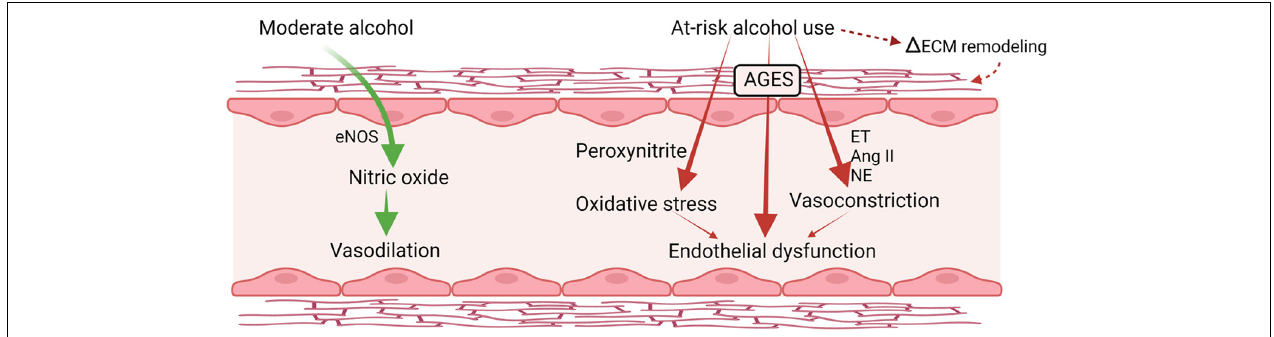
FIGURE 4 | Alcohol-induced biphasic effects on endothelial function. Acutely, moderate doses of alcohol increase production of nitric oxide and result in transient vasodilation. Chronic, heavy alcohol consumption produces oxidative stress and activates vasoconstrictor pathways including endothelins (ET) and angiotensin II formation (Ang II) that lead to endothelial dysfunction and altered response to vasoactive mediators. ET, endothelin; Ang II, angiotensin II; NE, norepinephrine; eNOS, endothelial nitric oxide synthase; AGES, advance glycation end products; ECM, extracellular matrix. Created with